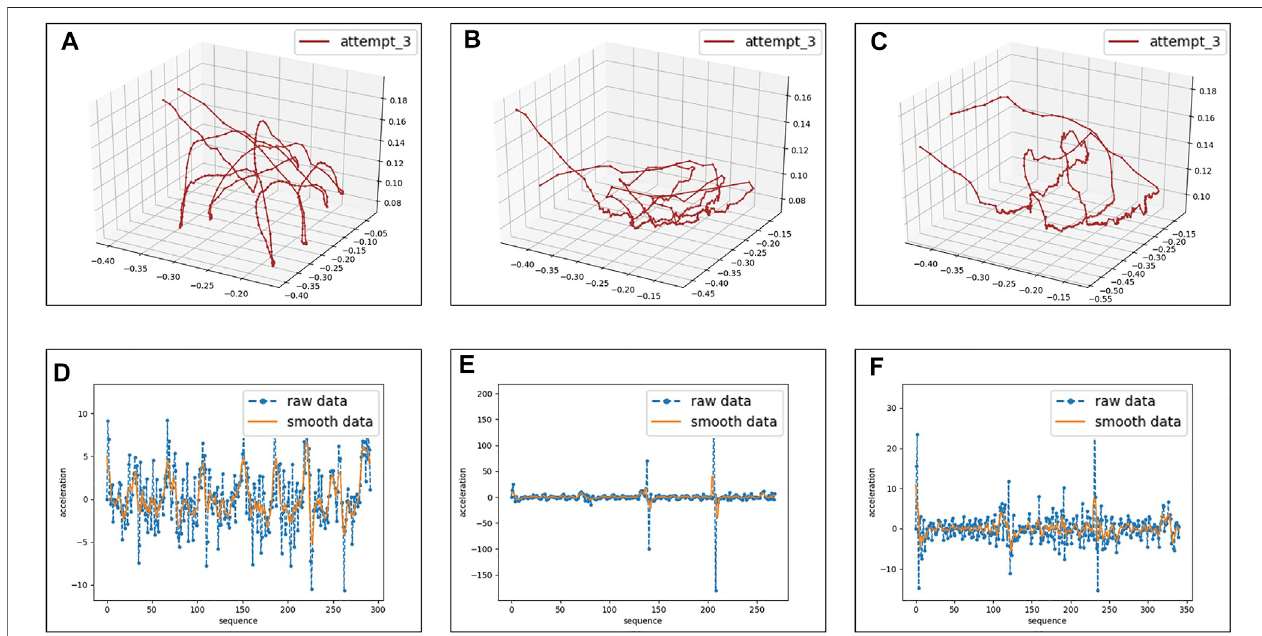
FIGURE 6 | Experiment results and analysis of the collected data. We plot the trajectory of the third attempt of task 2, task 3, and task 8 from a human operator in (A – C) .Operations(pushing,picking,orplacing)and(initialortarget)statecanbeeasilydistinguishedbyobservingthemotiontrajectory.Sub- fi guresfrom (D) to (F) atthe bottom line represent the corresponding acceleration sequence with and without smoothing. Motion-related data, such as position, velocity, and acceleration, provides a quanti fi able indicator of